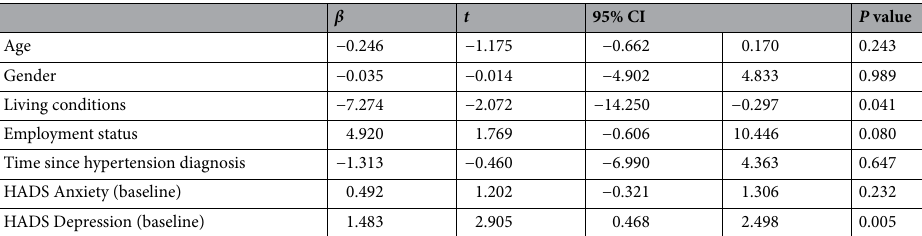
Table 3. Multiple linear impact of socio-demographic variables, and baseline anxiety and depression symptoms on IES-R (n = 96). Data are the unstandardized regression coefficients ( β ), the t-test value ( t ), and confidence interval (95%).